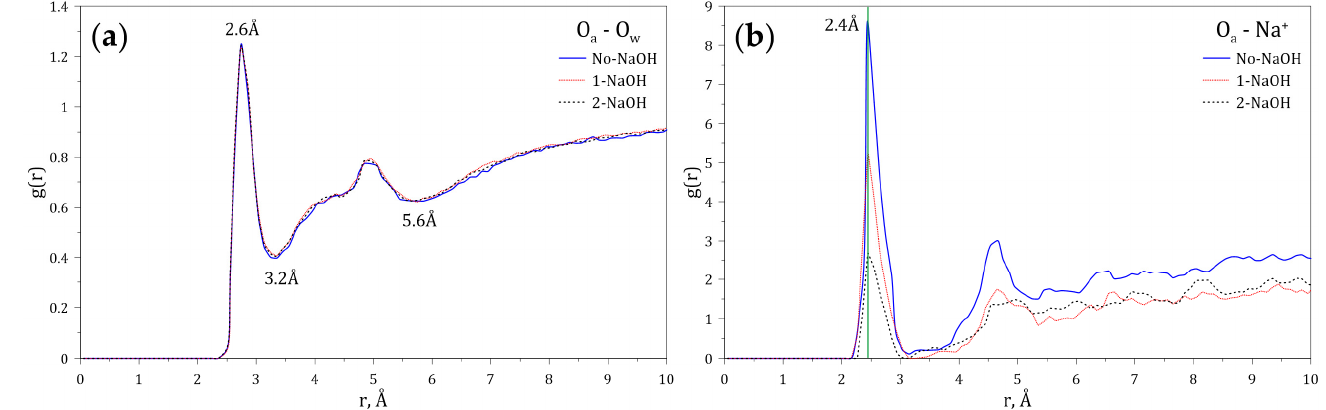
Figure 5. Radial distribution functions (g(r)) of ( a ) O w and ( b ) Na + interacting with the amide group of the HPAM at varying concentrations of NaOH.